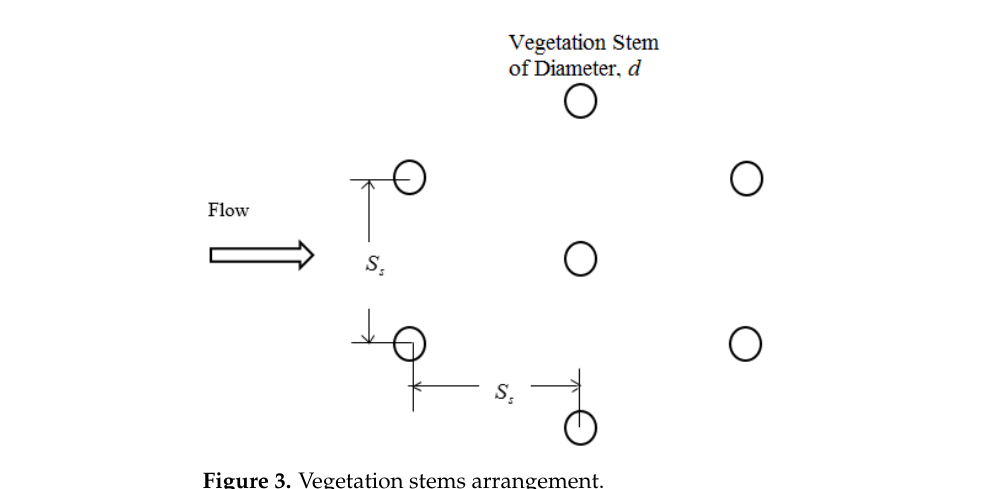
Figure 2. Flume setup.